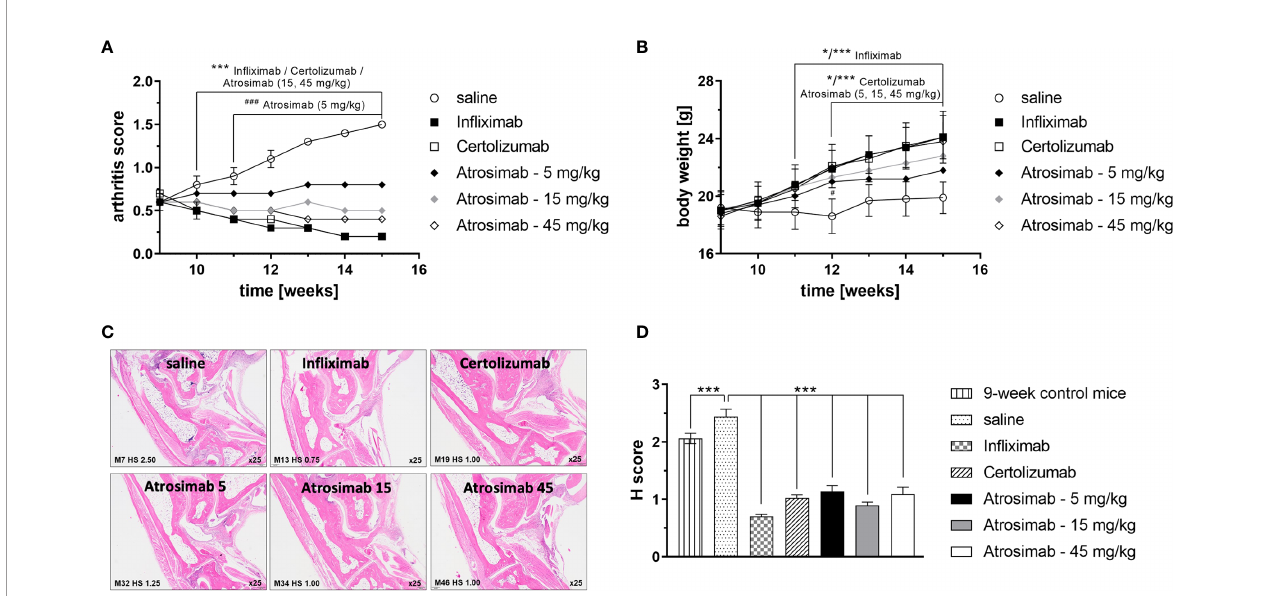
FIGURE 5 | Atrosimab is therapeutic for arthritic disease. Tg197hTNFR1KI transgenic mice were treated at an age of 9 weeks with saline, the anti-TNF therapeutics In fl iximab or Certolizumab pegol (15 mg/kg each), or different doses of Atrosimab by twice weekly s.c. injections. Arthritis score (A) and weight (B) were documented weekly. (C, D) Histopathological analysis of the joints was performed at an age of 15 weeks and compared to 9-week-old non-treated mice. Shown are representative pictures and quanti fi cation of the histological (H) score. Mean ± SD, n=8, *p < 0.05, ***/ ### p <